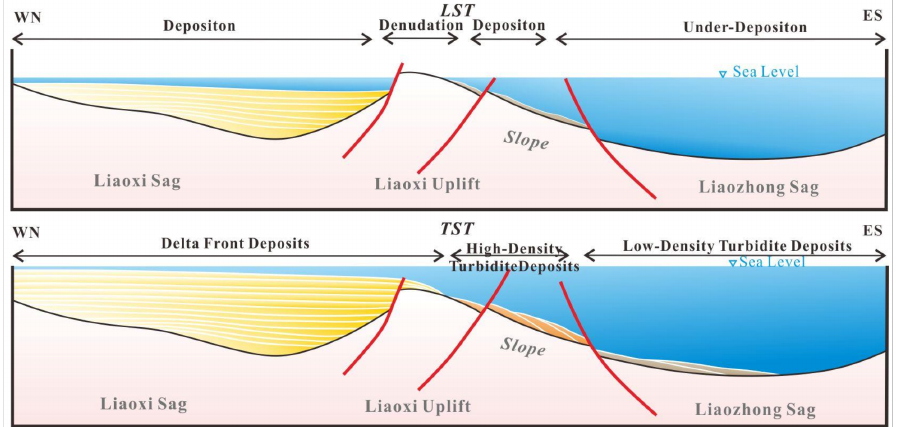
Figure 15. Patterns of sag filling by the distal source. In the LST, the Liaoxi uplift was exposed to the water surface, preventing the distal source from entering the uplift. In the TST, the uplift was located underwater, and the distal source entered the uplift, providing provenance for the sublacustrine